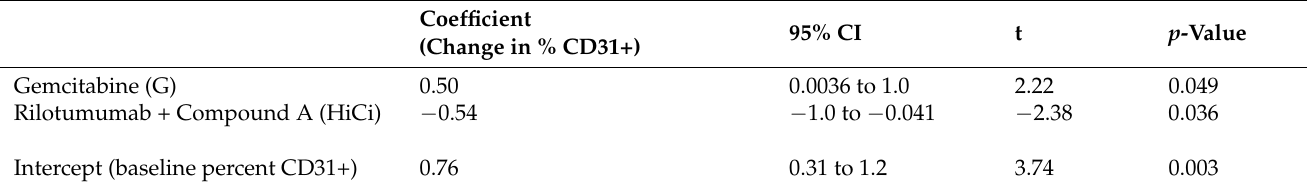
Table A6. Model specification for Figure 2c: Linear regression model of CD31 positive area as a percentage of tumour cross sectional area.